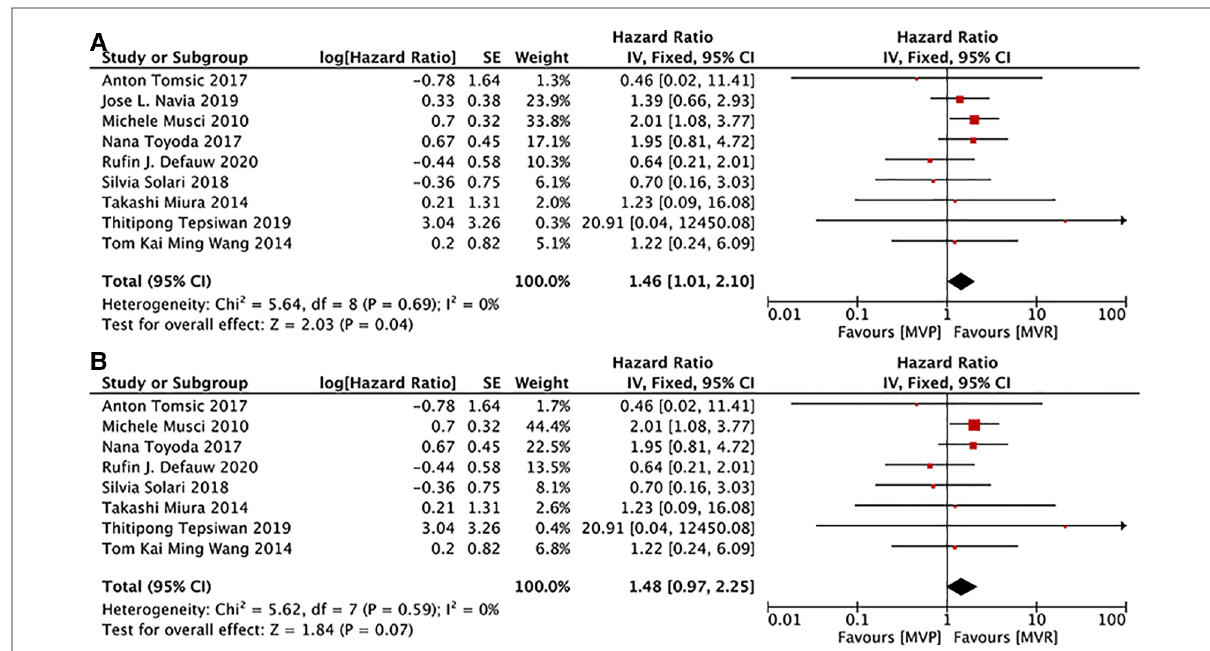
FIGURE 5 Meta-analysis for freedom from reoperation due to all-events: ( A ) MVP vs. MVR; ( B ) MVP vs. MVR (active IE); MVP, mitral valve plasty; MVR, mitral valve